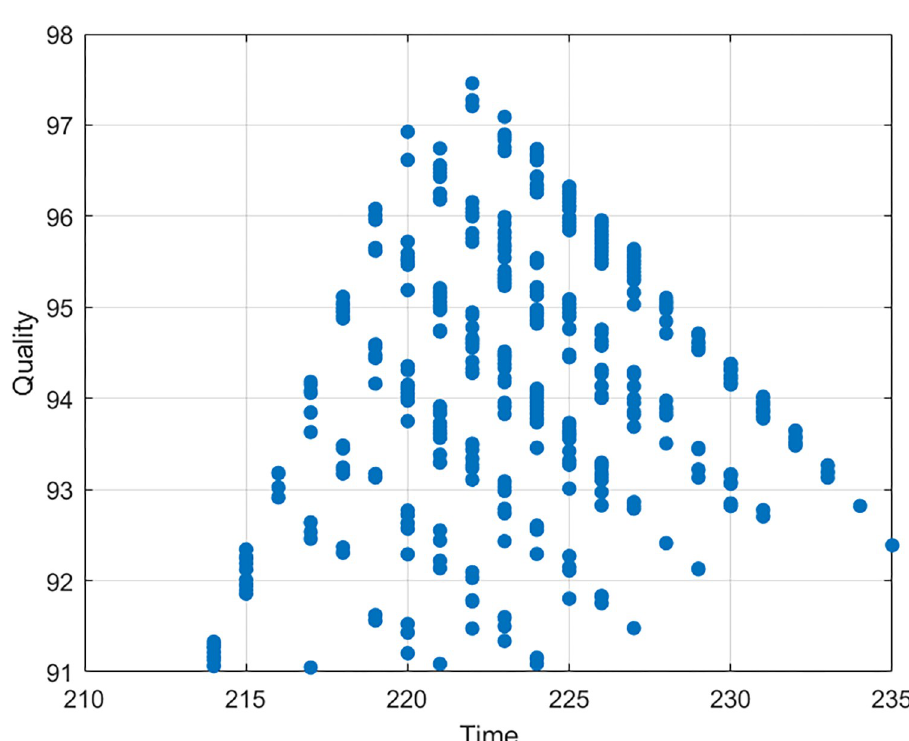
Fig 14. Time-quality tradeoff